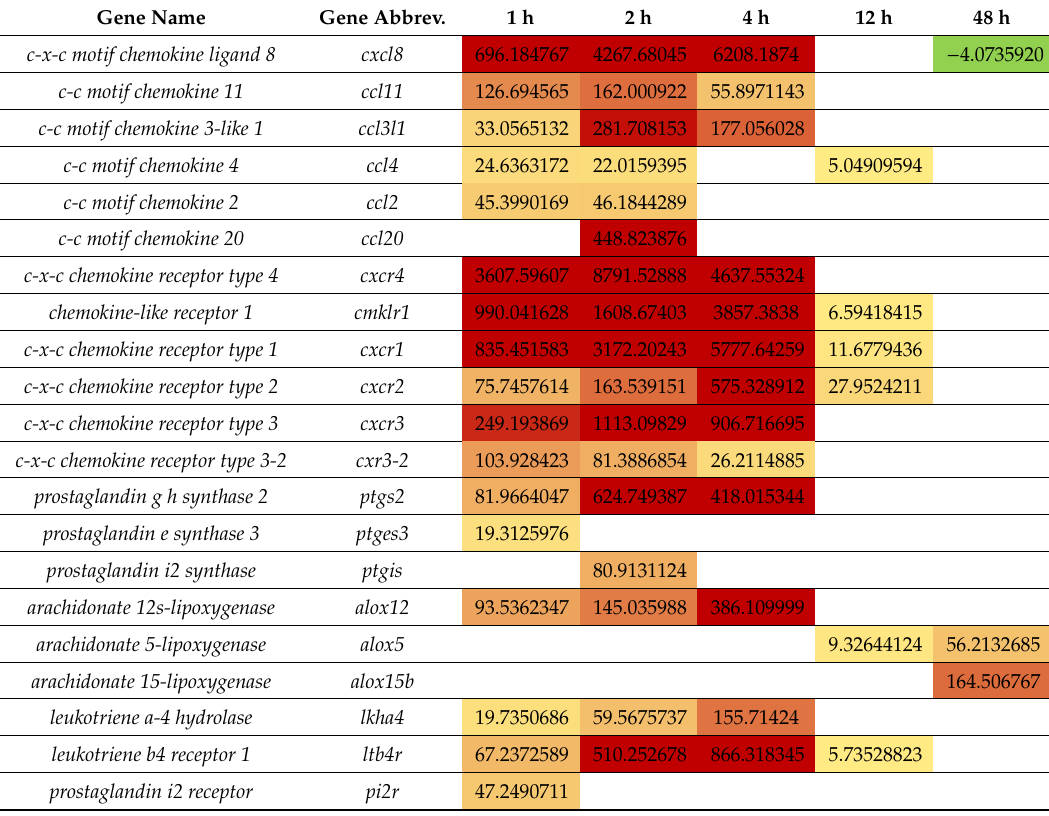
Table 4. Heat map showing a group of DE genes in turbot peritoneal cells at 1, 2, 4, 12 and 48 hpi, including several genes coding for chemokines, chemokine receptors and enzymes involved in prostaglandin synthesis. Results are expressed as mean expression ratios of groups 1, 2 and 4 hpi vs. 0 h, or 12 and 48 hpi vs. PBS. Red indicates increased gene expression levels; green indicates decreased